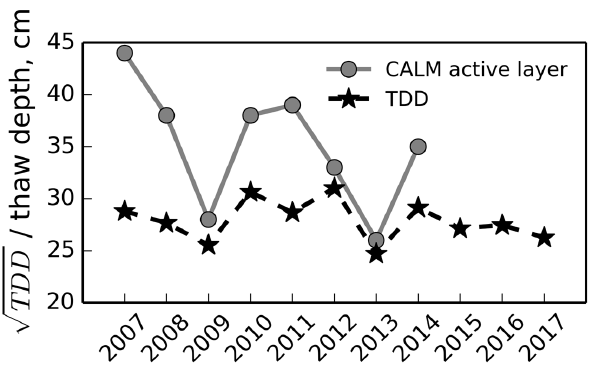
Figure 10. Thaw depth from Circumpolar Active Layer Monitoring (CALM) measurement site R29A and square root of thawing degree days (TDD) calculated from daily averaged air temperatures from a nearby meteorological station for the last decade.